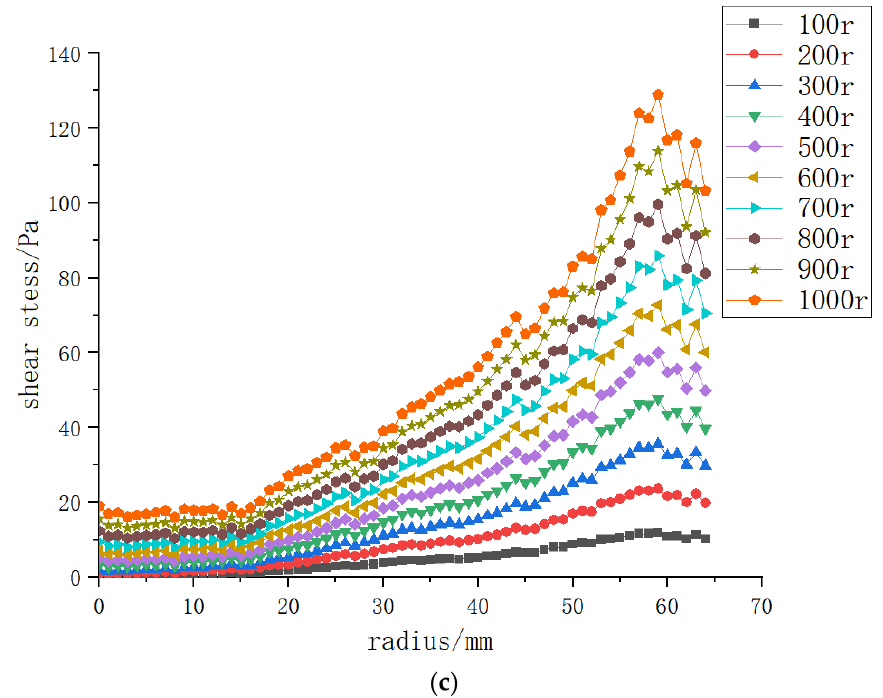
Figure 8. The shear force on the membrane surface of three structures at rotating speeds of 100–1000 r/min and a transmembrane pressure difference of 0.5 bar: ( a ) vane ( b ) disk ( c ) propeller.